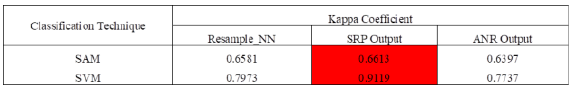
Table 2. OA Values for SAM and SVM